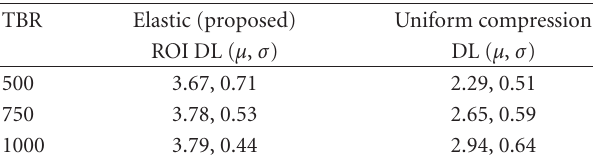
Table 7: Averaged results for DL at 500kbps, 750 kbps, and 1000 kbps (diagnostic level quality scale: 1-no, 2-maybe not, 3- likely,